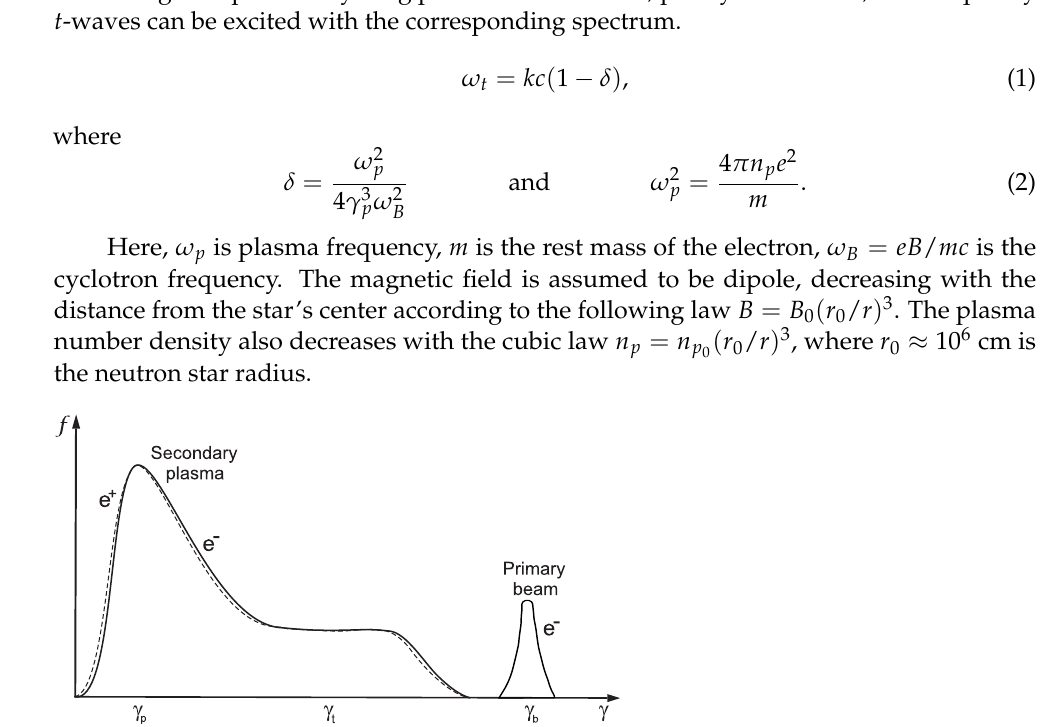
where ω c is the resonance frequency of the excited cyclotron modes, γ res is the Lorentz factor of the resonant particles, k (cid:107) and υ (cid:107) are the components of the wave vector and the particle velocity along the magnetic field, respectively. During the wave generation process by resonant particles, one also has a simultaneous back reaction of t -waves on the particles [34]. This mechanism is described by quasi-linear diffusion (QLD), leading to the diffusion of particles along and across the magnetic field lines. Therefore, resonant